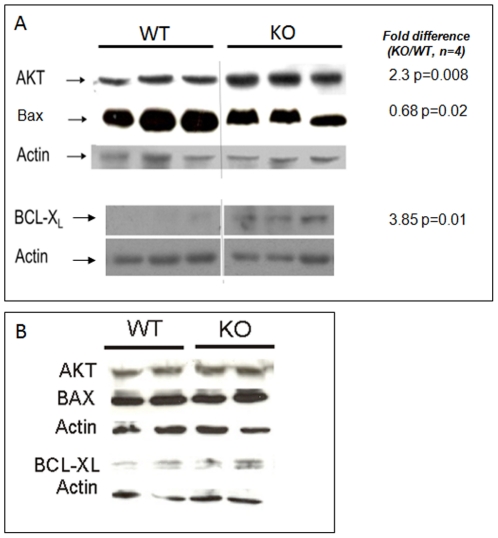
Lack of nm23-M1 results in diminished apoptosis markers in the virgin but not the lactating mutant glands.A: protein extracts from 6 weeks old virgin WT and nm23-M1−/− (KO) glands were processed for western-blotting. Images were analyzed by densitometry to measure intensity differences between the two groups. Results are indicated on the right hand side. B: protein extracts from L1 lactating WT and nm23-M1−/− (KO) glands were processed for western-blotting. No difference in band intensity was evidenced between the two groups.